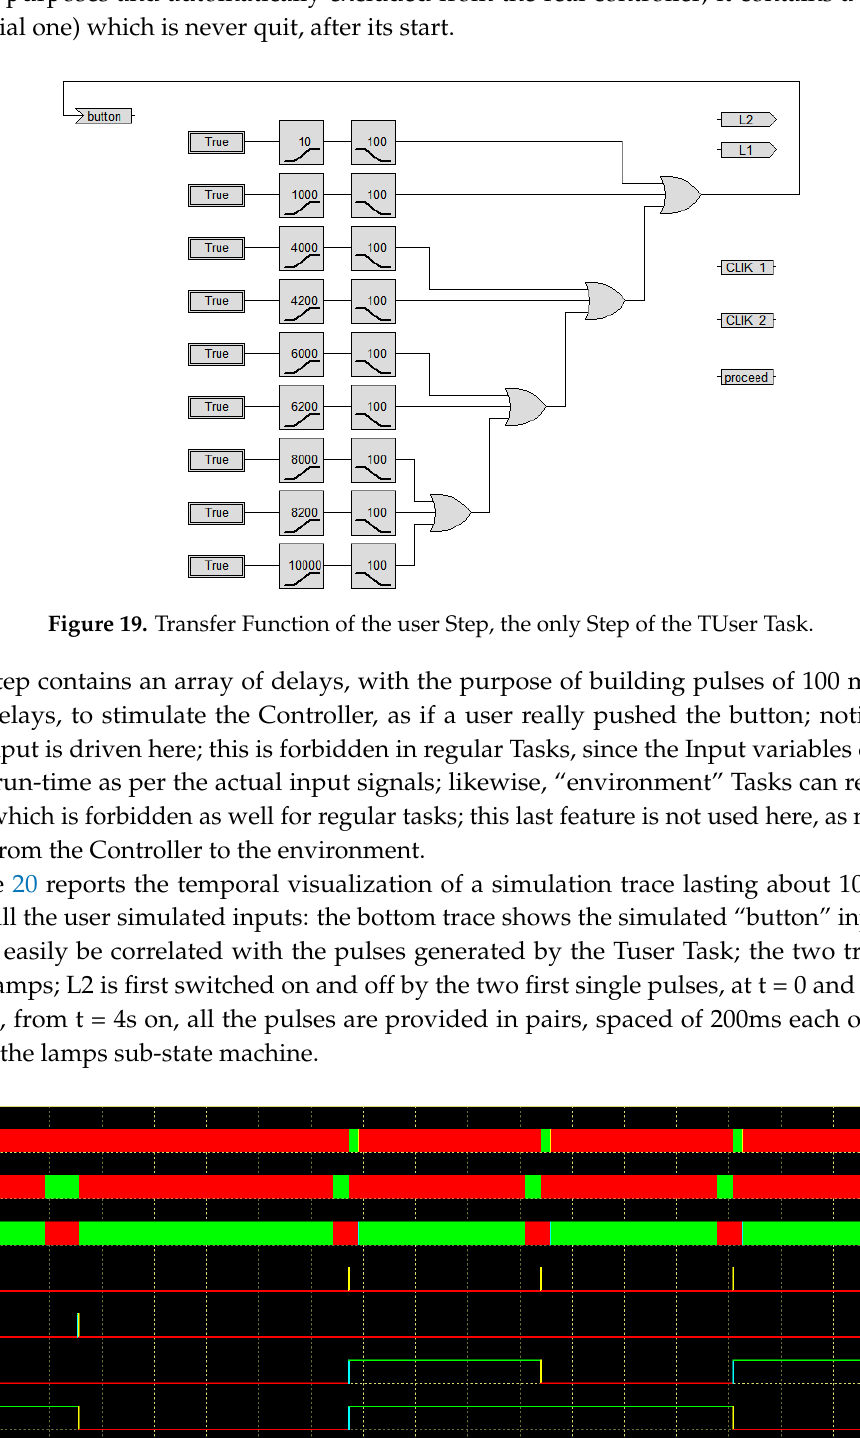
Figure 18. Data Flow of Steps waitClk ( a ) and wait2Clk ( b ).